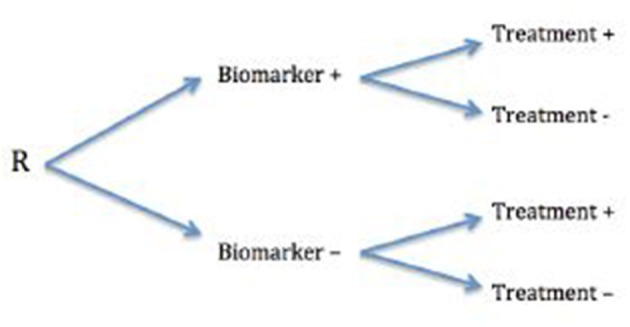
Retrospective assessment (R) of biomarkers influencing treatment decisions.